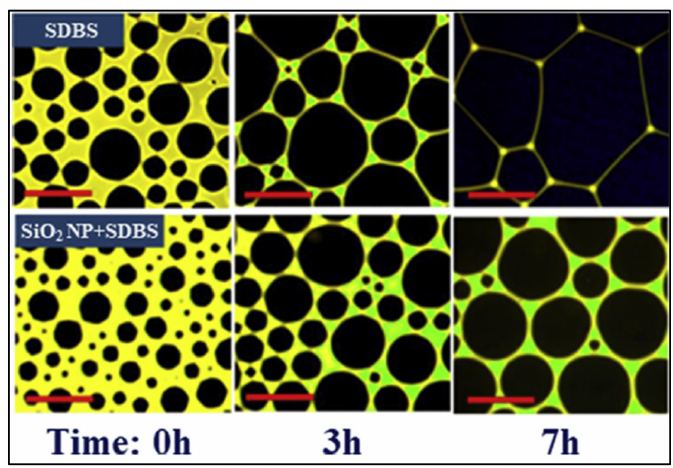
Figure 26. The change in foam microstructure enhanced by nanoparticle (Reprinted with permission from Lv et al. [47]). Copyright 2015, American Chemical